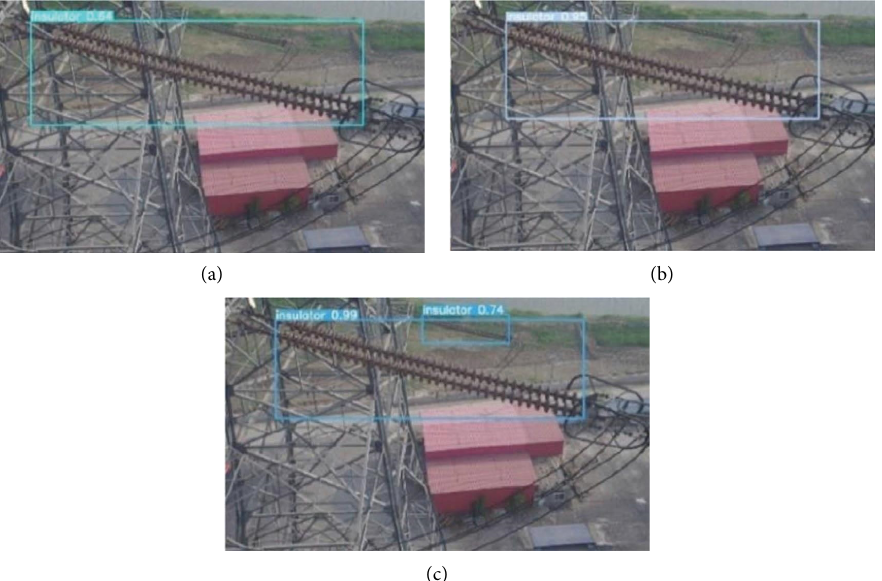
Figure 8: Insulator detection results of diferent test methods. (a) Reference [16]. (b) Reference [17]. (c) Proposed